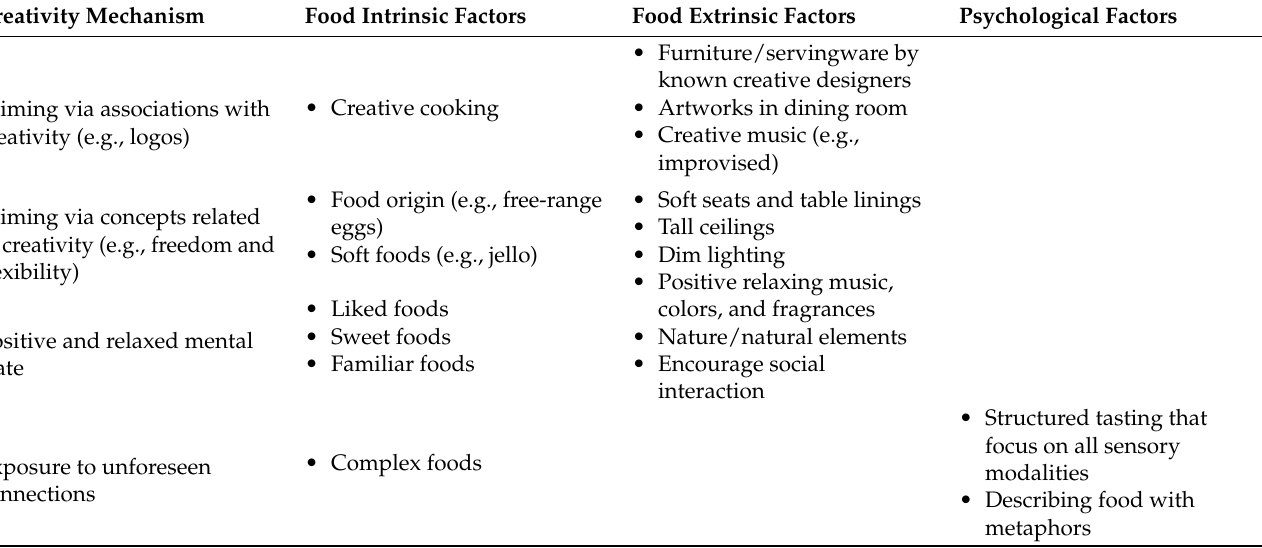
Table 2. A summary of ways in which the sensory aspects of the holistic eating experience might enhance creativity. Creativity Mechanism Food Intrinsic